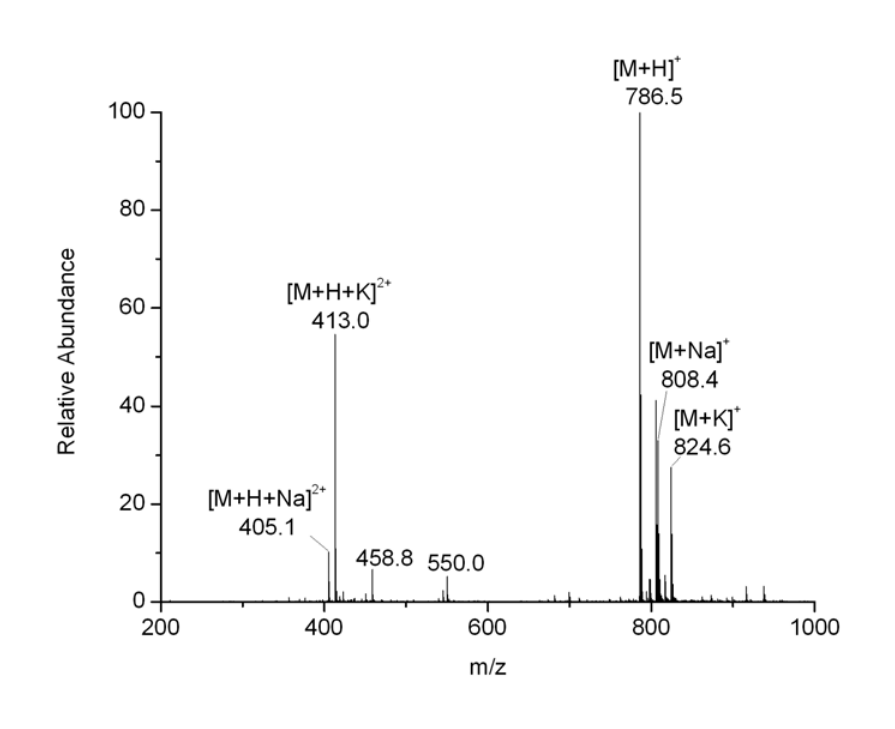
Fig. 5 ESI full scan spectrum of crude heptapeptide 2